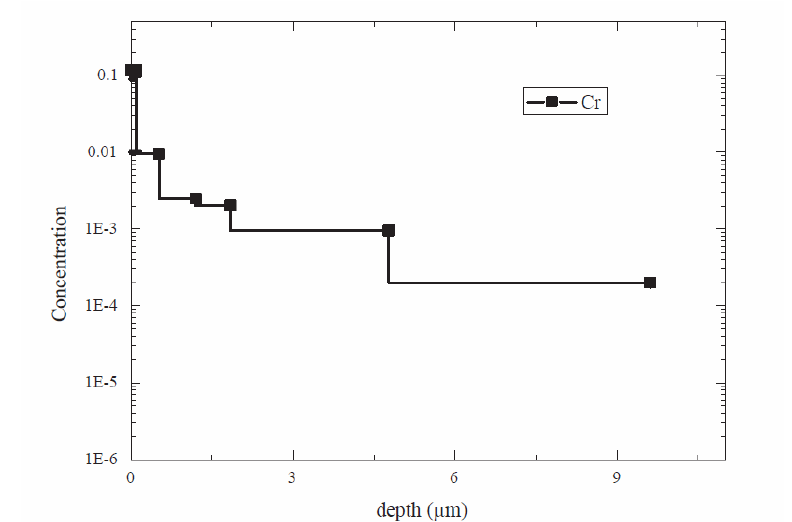
Figure 4 – Deuterium depth profile for the Cr samples annealed in vacuum at 873 K for 1h and then exposed to deuterium plasma at 300 K to a fluence of F = 6×10 24 Dm -2 Slika 4 – Dubinski profil deuterijuma za uzorke Cr zagrevane u vakuumu na 873K u trajanju od 1h, a zatim ozra č ene plazmom deuterijuma na 300 K pri